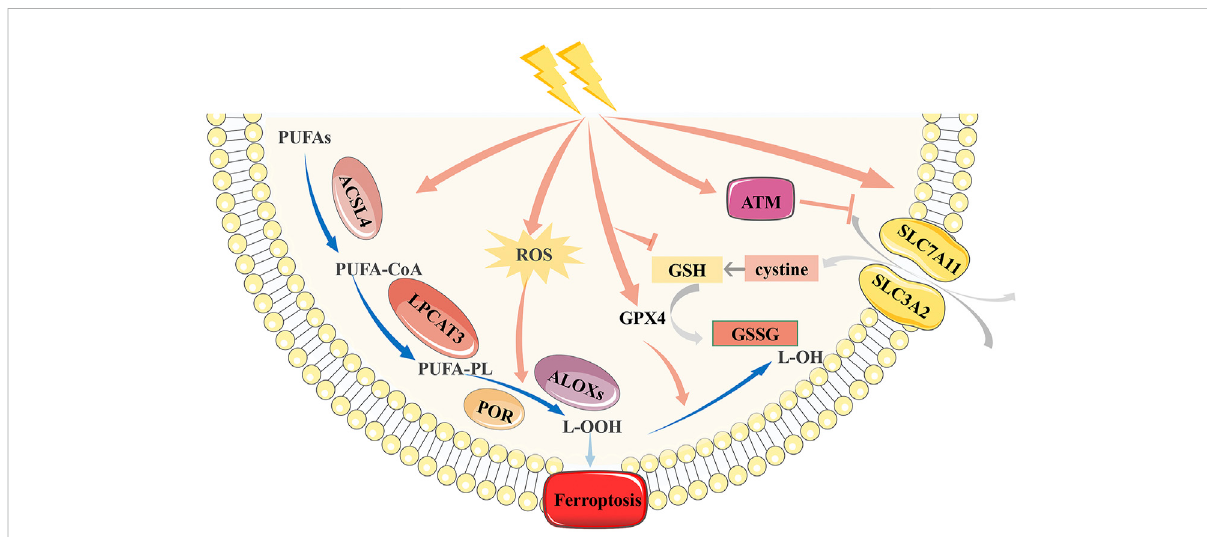
FIGURE 2 Mechanism of ferroptosis induced by radiotherapy. Radiation can inhibit the antioxidant function of SLC7A11 and GSH, and up-regulate the expression of ACSL4, thus inducing ferroptosis. However, radiation can aslo up-regulate the expression of SLC7A11 and GPX4 due to